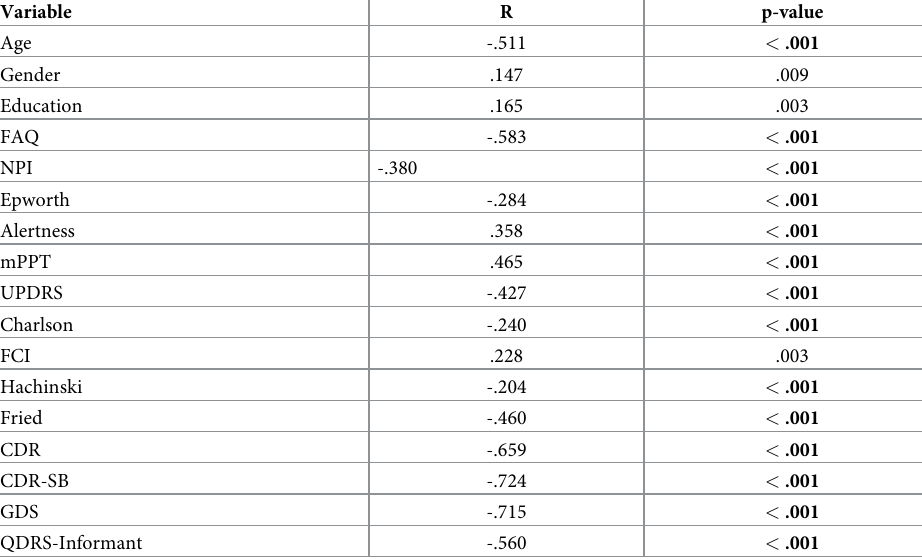
Table 1. Construct validity with clinical